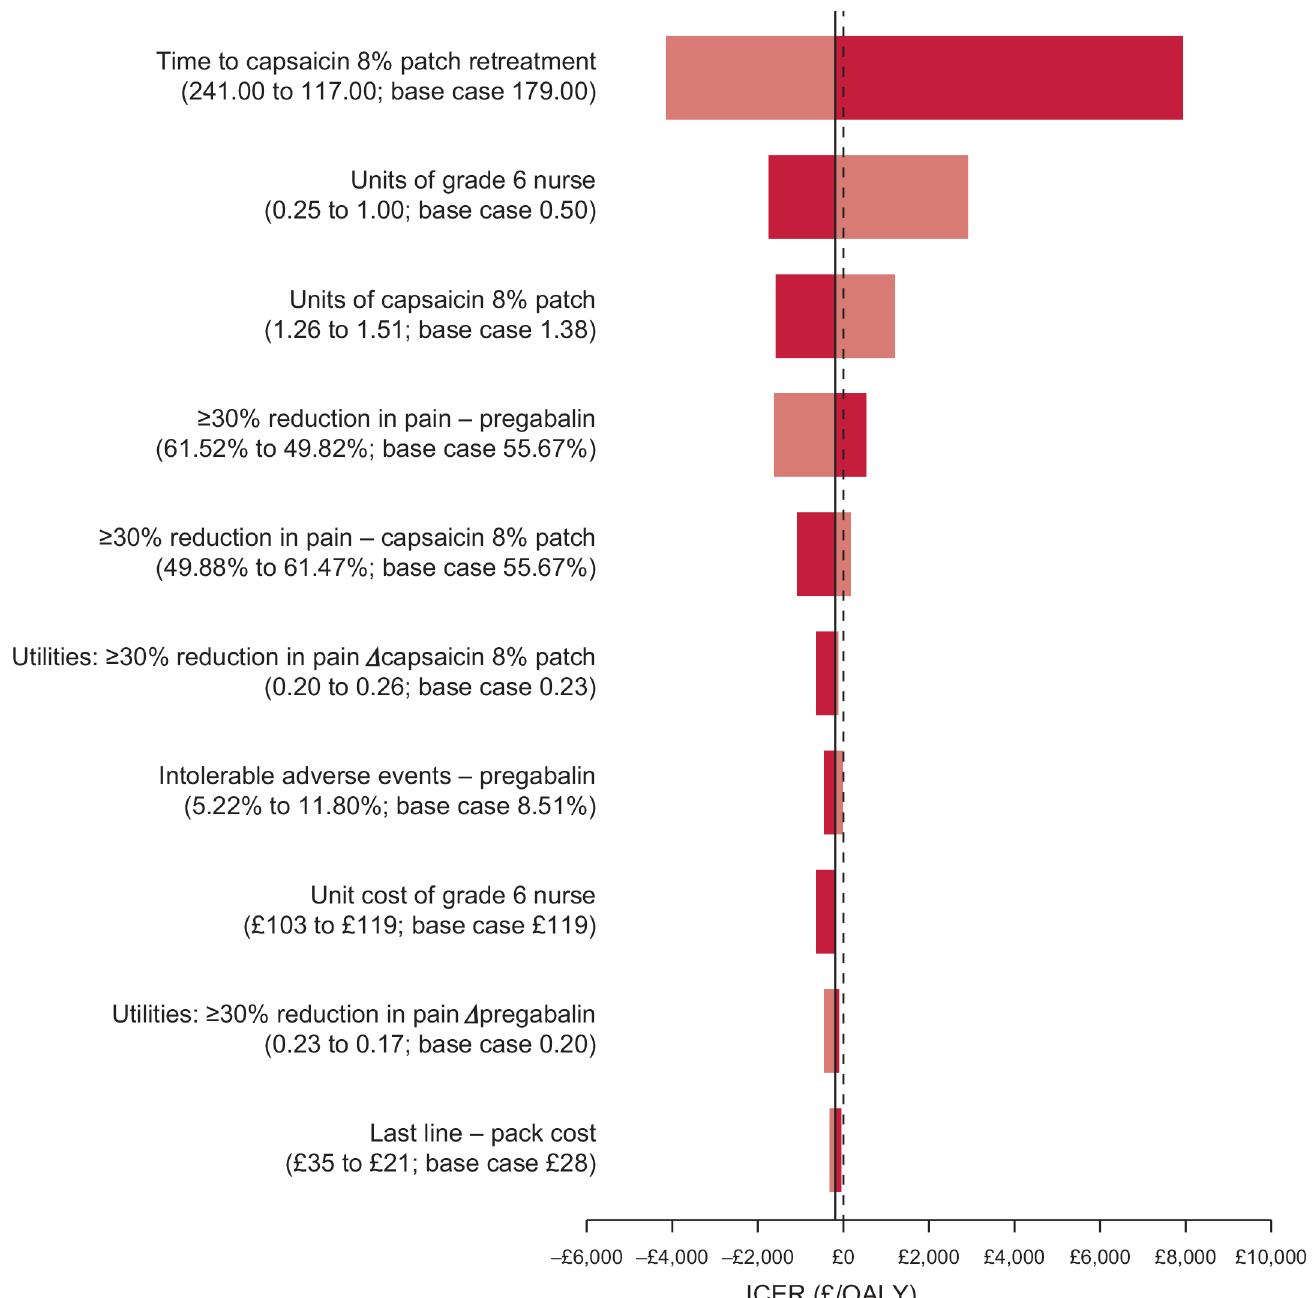
Fig 2. One-way sensitivity analysis (2-year time horizon). Key: Each bar represents the ICER values associated with using the low (dark shading) and high (light shading) parameter values. The dotted line represents the base-case